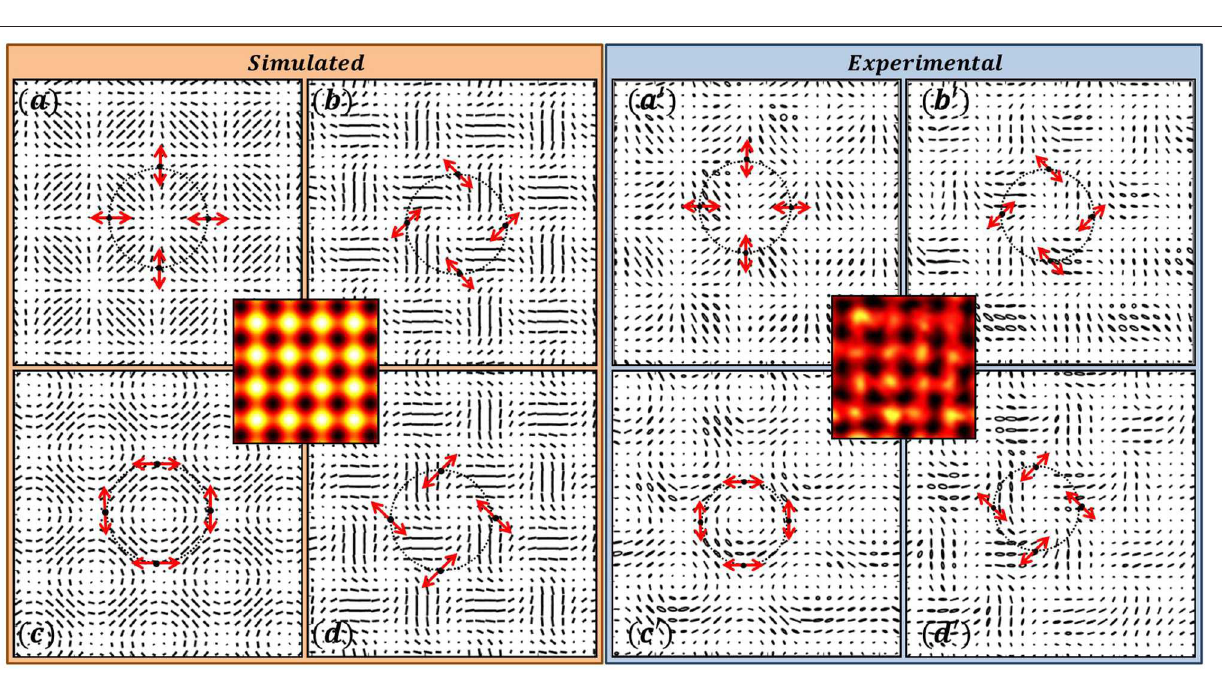
FIGURE 6 | Four Beam Interference producing lattice of V-points. The SOPs of the four plane waves are derived from a V-point with η = + 1. having radial, spiral, and azimuthal SOP distributions. (a–d) Simulation; (a ′ –d ′ ) Experimental